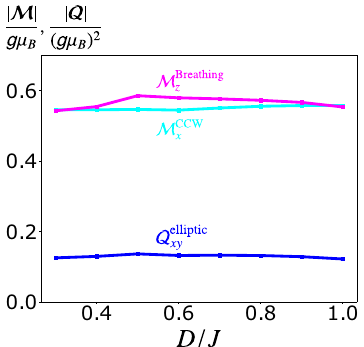
FIG. 9. Dynamical magnetic dipole moment M and quadrupole moment Q of magnons are independent of the size of skyrmions. The dimensionless amplitudes of M /( g μ B ) and Q /( g μ B ) 2 are plotted as a function of D / J . For each value of the D / J ratio, the classical ground-state spin con- figuration of SkXs is obtained at g μ B B z J /( D 2 S ) = 0.8, where N b = [576, 361, 256, 169, 144, 121, 100,